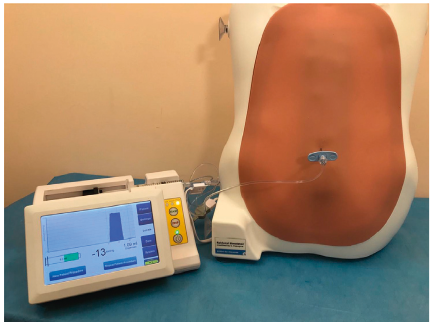
Figure 1: Experimental setting: the CompuFlo ® and the epidural simulator used. Figure 2: Magnification of the inner portion of the epidural